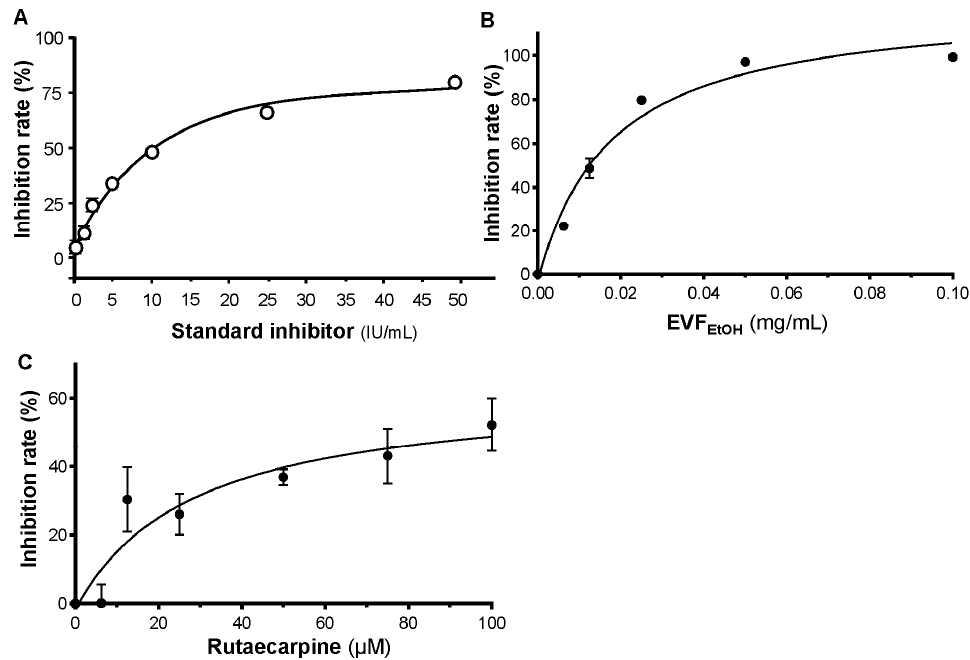
Figure 3. EVF EtOH and rutaecarpine inhibit the binding of S-protein to ACE2. ( A ) A standard inhibitor (calibrated to NIBSC code 20/136) was utilised as a positive control. EVF EtOH ( B ) and rutaecarpine ( C ) both disrupted the binding between the S-protein and the ACE2 receptor. The data represent the mean ± SD percentage of inhibition to control (with no drug treatment), and n = 4.